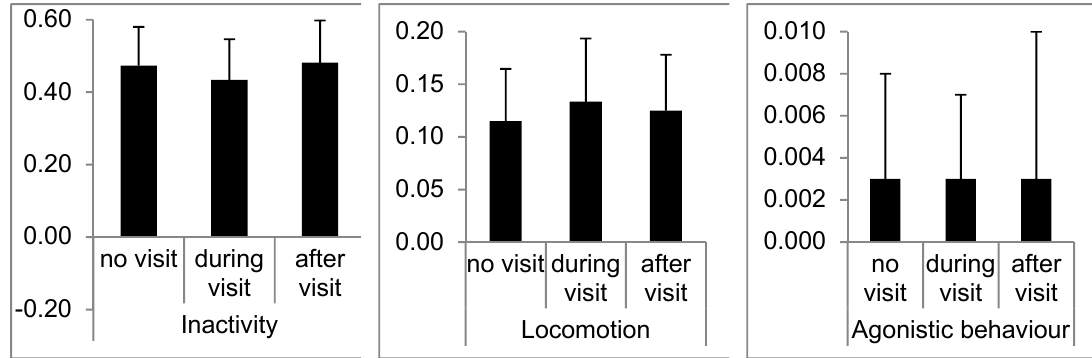
Figure 3. Averages of inactivity, locomotion and intra-group agonistic behavior according to visitor presence (none, visit, after).